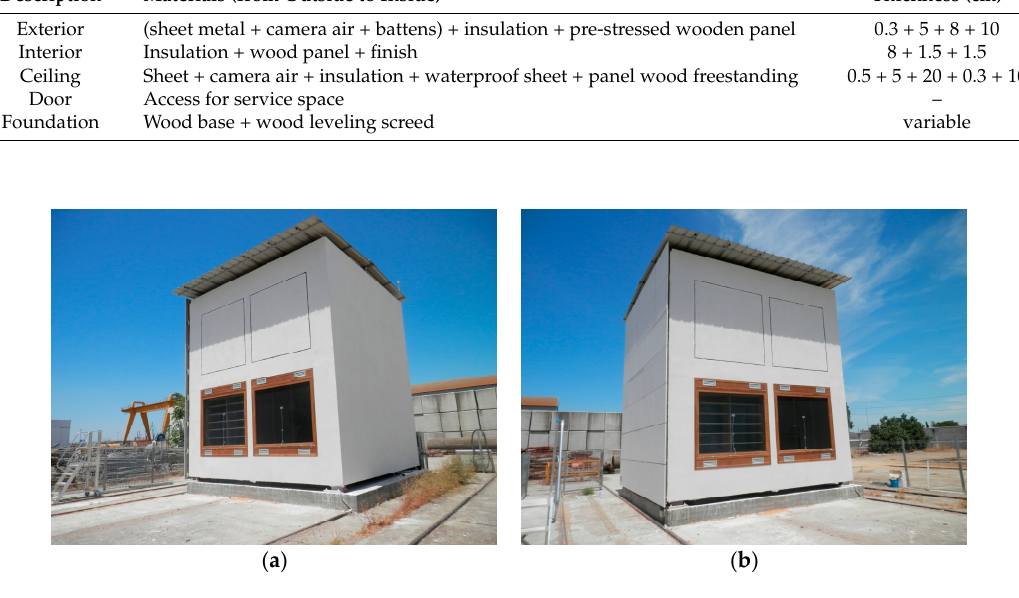
Figure 4. General view of the prototype solar ( a ), on the right ( b ) facing south-east direction. Table 3. The enclosure materials used in the actual prototype.